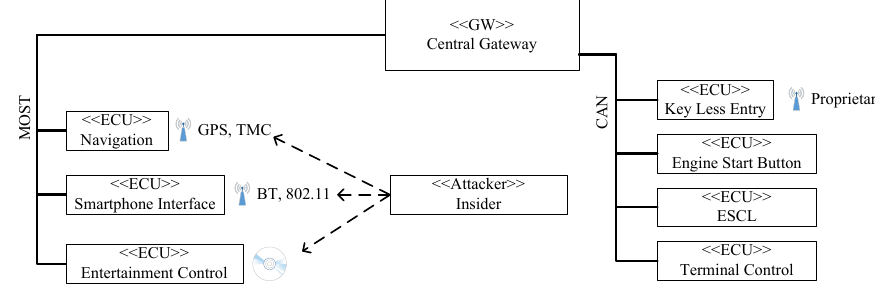
Figure 15. Sub-architecture and attacker type Insider with non-physical access.